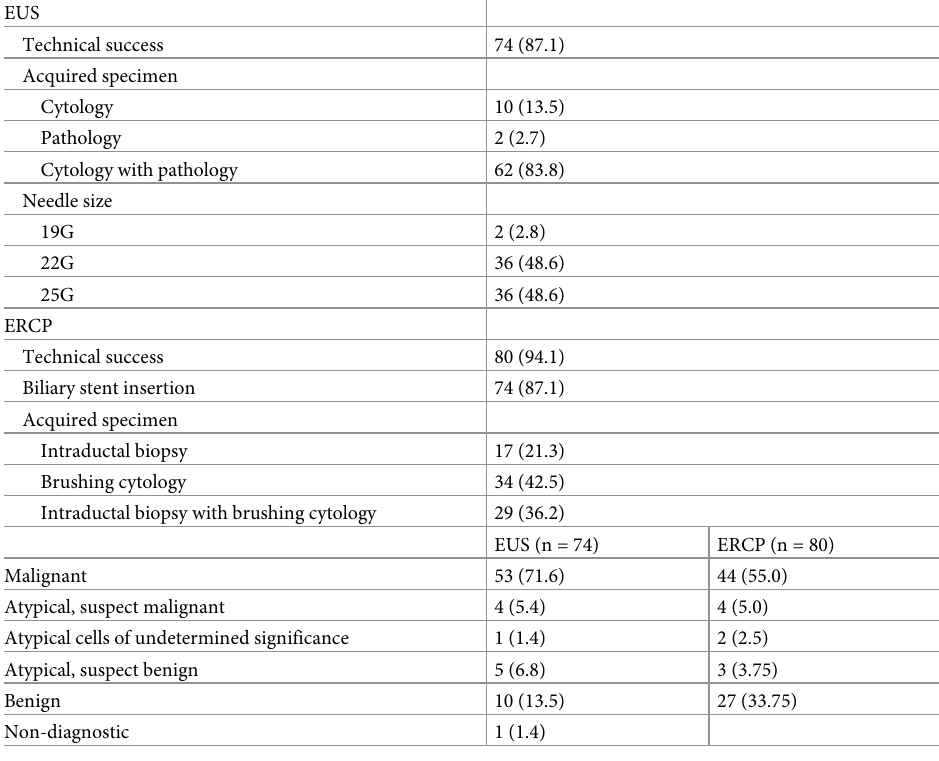
Table 2. Results of EUS and ERCP-based tissue